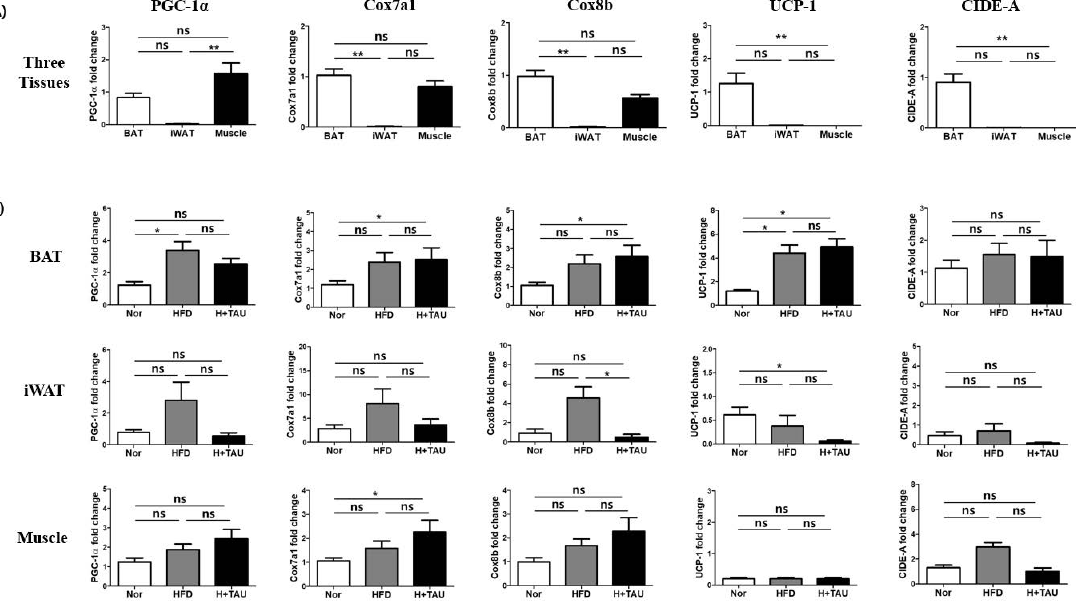
Figure 2. E ff ects of taurine on transcriptional expression of thermogenesis-related genes in tissues. ( A ) The basal mRNA expression levels of PGC-1 α , Cox7a1, Cox8b, UCP-1, and CIDE-A were compared to determine the relative expression of the genes from the three tissues in the normal diet fed (N) group: inguinal white fat tissue (iWAT), interscapular brown fat tissue (BAT), and quadricep muscle tissues. ( B ) The mRNA expression levels of the genes in iWAT, BAT, and muscles of the three groups were compared to determine how HFD and / or taurine supplementation a ff ected the gene expression of each tissue of the three groups; N normal diet group ( n = 5), HFD high-fat diet group ( n = 5), and H + Tau HFD + taurine (2% in drinking water) group ( n = 5). Di ff erences between the three groups were analyzed using the nonparametric Kruskal–Wallis test. If a statistical di ff erence was detected ( p < 0.05), post hoc pairwise group comparisons were performed using Dunn’s test with Bonferroni multiple-testing correction. The P values of the two groups were included to show the expression di ff erence of thermogenesis-related genes. Di ff erences were considered statistically significant at p < 0.05. ** p < 0.01; * p < 0.05; ns not significant. N normal diet group, HFD high-fat diet group, H + Tau HFD + taurine (2% in drinking water)